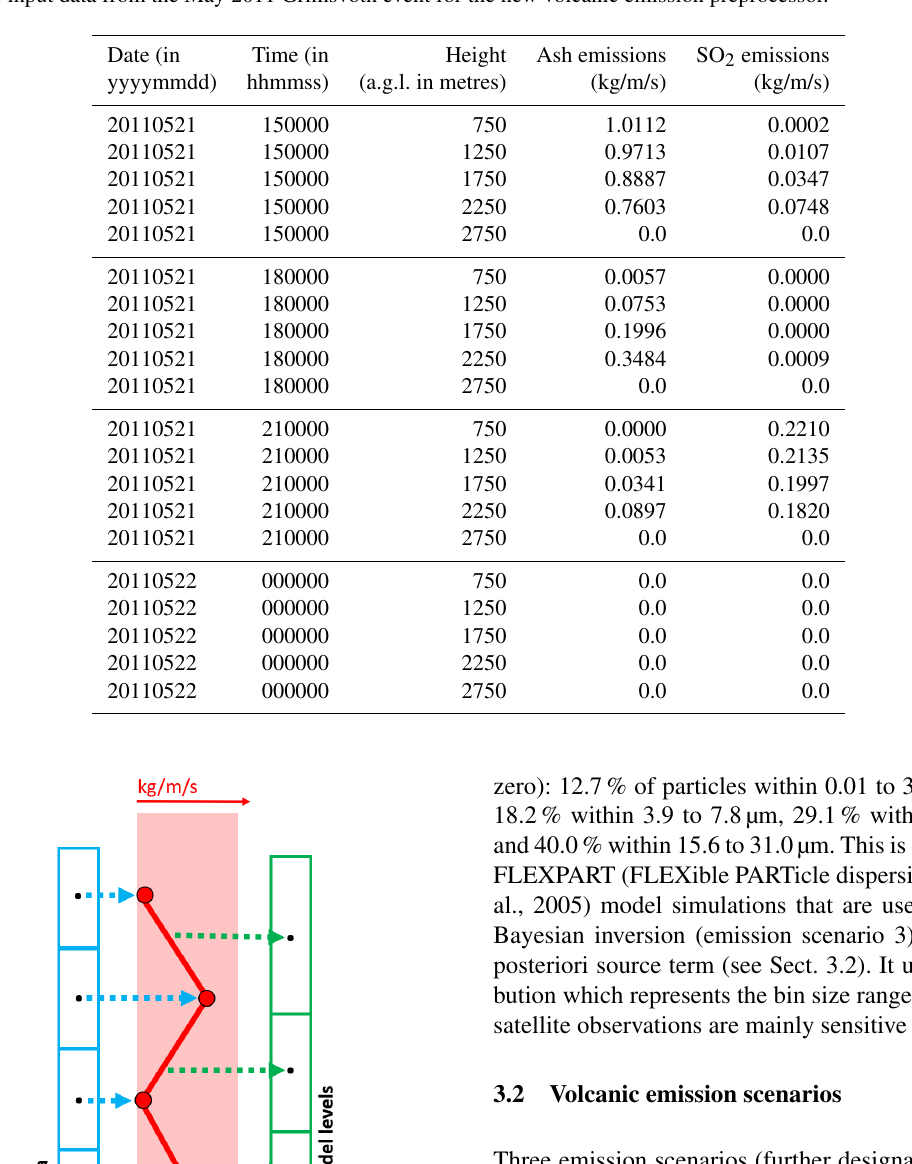
Table 1. Example input data from the May 2011 Grimsvötn event for the new volcanic emission preprocessor.